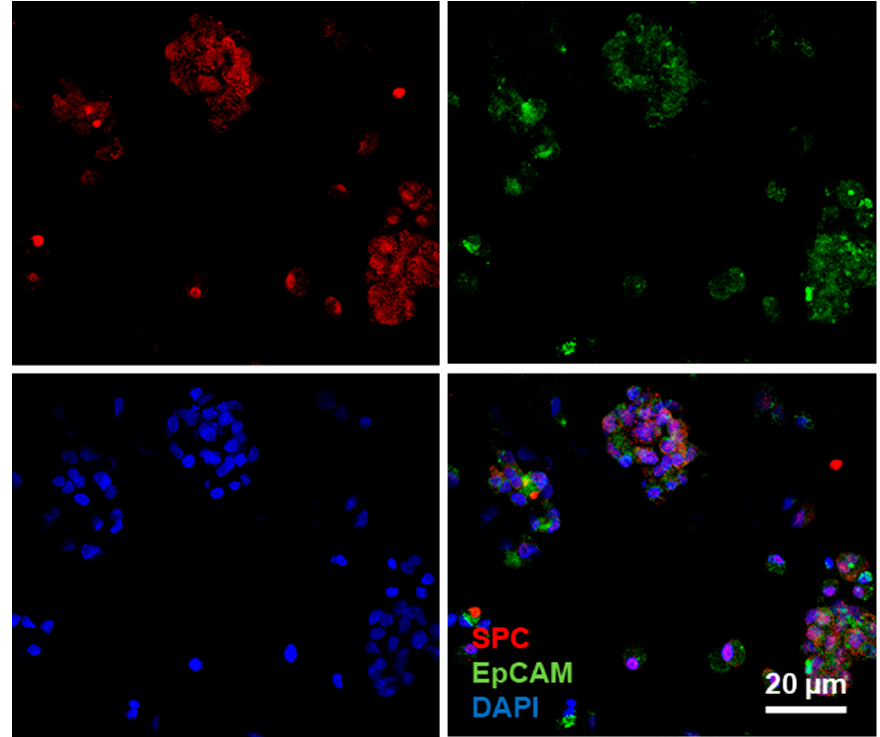
Figure 6. Alveolar type II cells were cultured on hydrogels for three days. After that time, they were subcultured on plates and stained for surfactant protein C (red) and EpCAM (green).